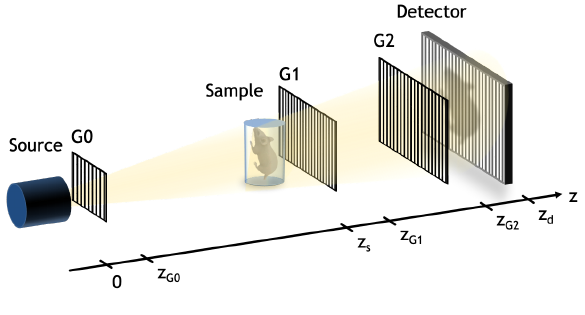
Figure 5. Grating interferometer imaging set-up. A beam from a very coherent source or from a source collimated by a G0 grating is emitted towards the sample. A grating G1 placed before or after the sample creates a Talbot carpet interference pattern. The grating G2 filters the peaks of intensity that have been deviated from the axis before the detector. Several acquisitions are required with various positions of G1 and